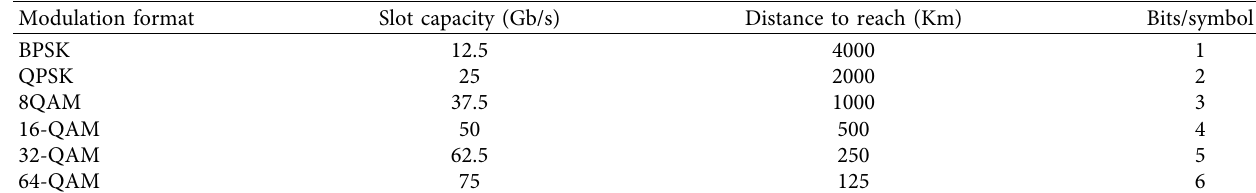
Table 3: Te modulation format parameters are used in simulations.